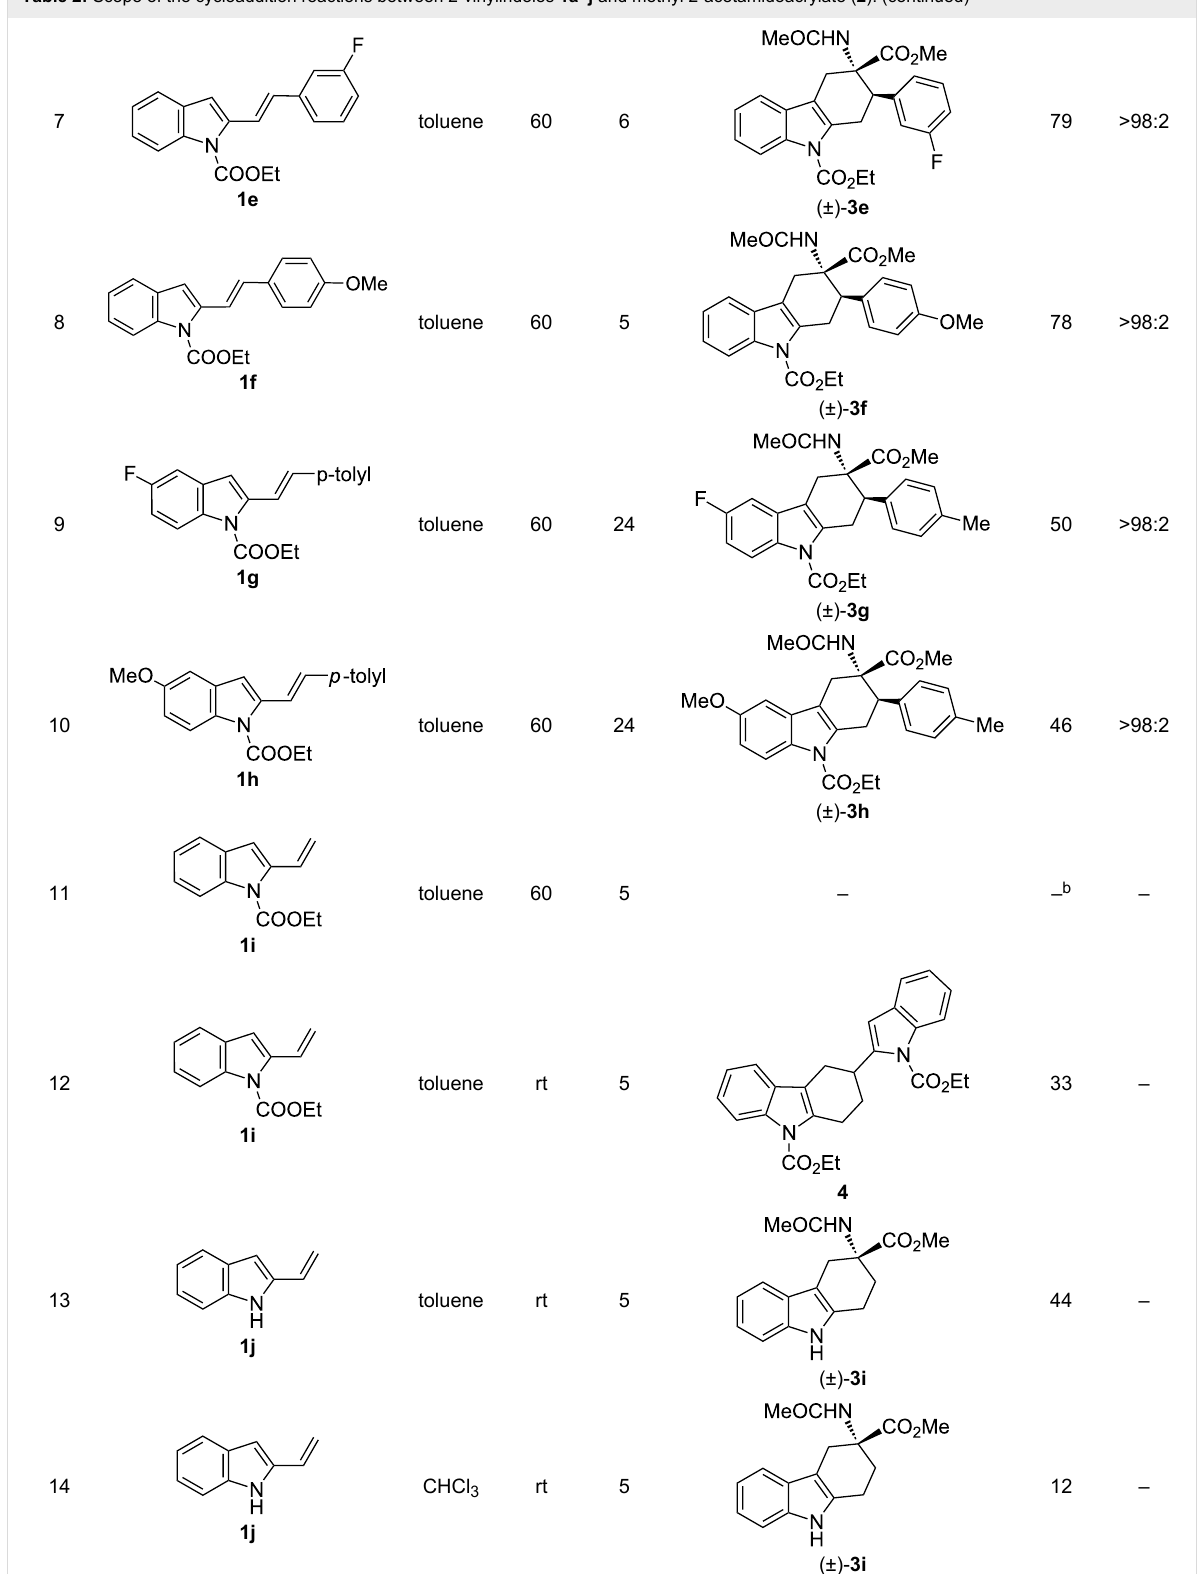
Table 2: Scope of the cycloaddition reactions between 2-vinylindoles 1a–j and methyl 2-acetamidoacrylate ( 2 ).